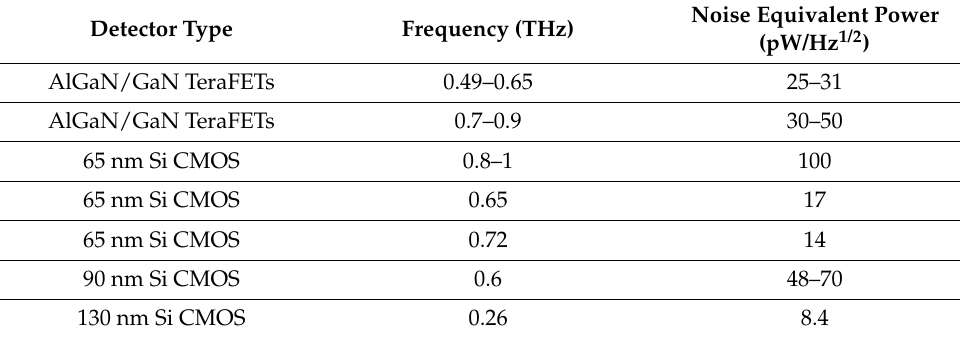
Table 1. TeraFET detector performance at sub-THz and THz frequencies (data from [82]).